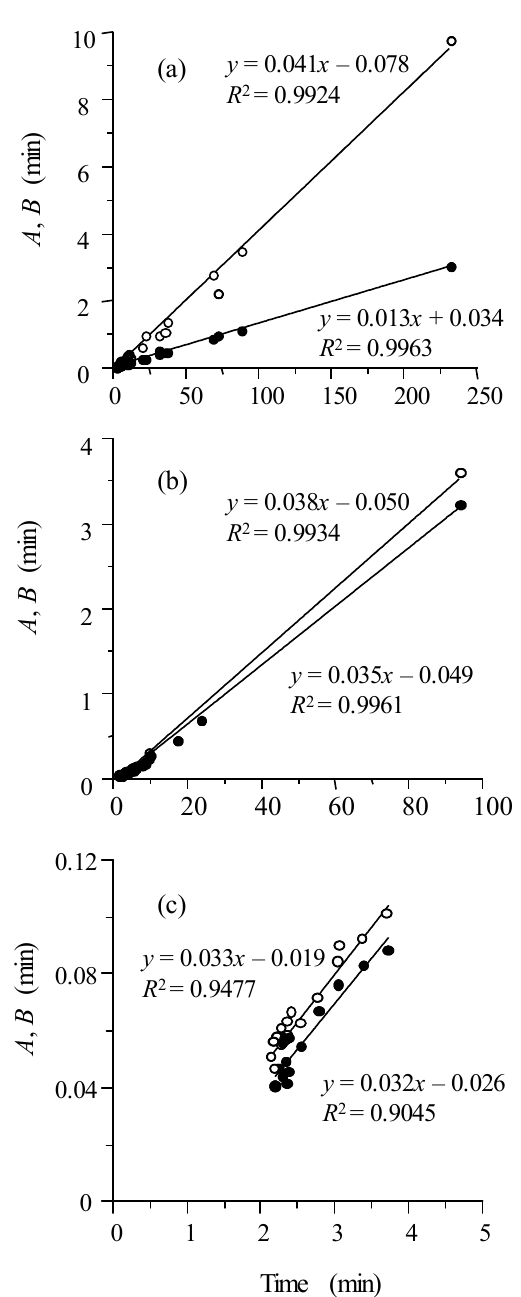
Figure 3. Half-width plots (left, A (●) and right, B ( ○ ) ) built with the whole set of data for the eight basic compounds eluted with all assayed mobile phases in: ( a ) RPLC without additive, ( b ) RPLC with [C 6 C 1 im]Cl, and ( c ) HILIC.